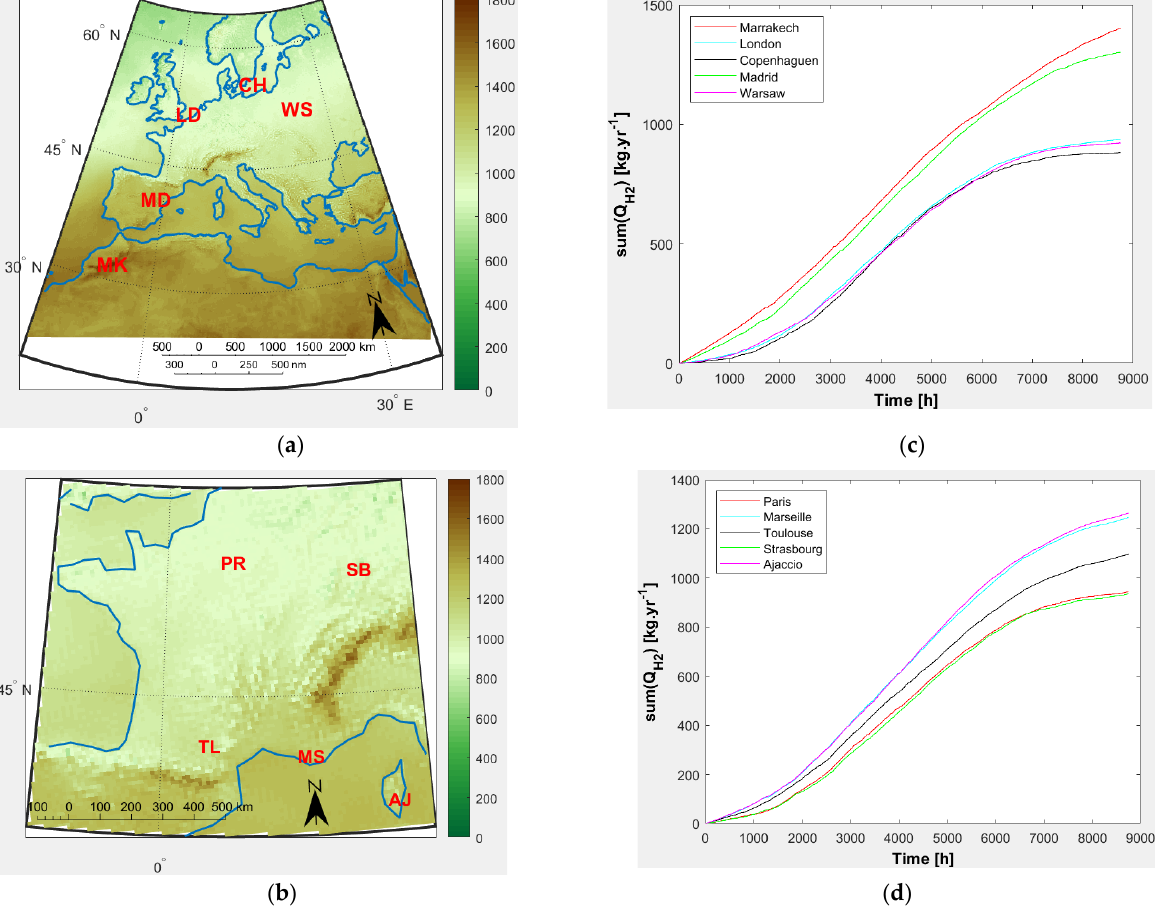
Figure 2. H 2(g) resource maps (kg·yr −1 ) for a 100 kW p PV plant (year 2005, historical data). ( a ): Europe; ( b ): France. H 2(g) mass production profiles (kg·yr −1 ) versus time for year N ref = 2005: ( c ): Europe; ( d ): France. Red letters: city abbreviations (see Table 1). Table 4. Simulation results for yearly H 2(g) local capacities [kg·yr −1 ], equivalent energy [MWh·yr −1 ] and others physical parameters for year 2005 (historical data).